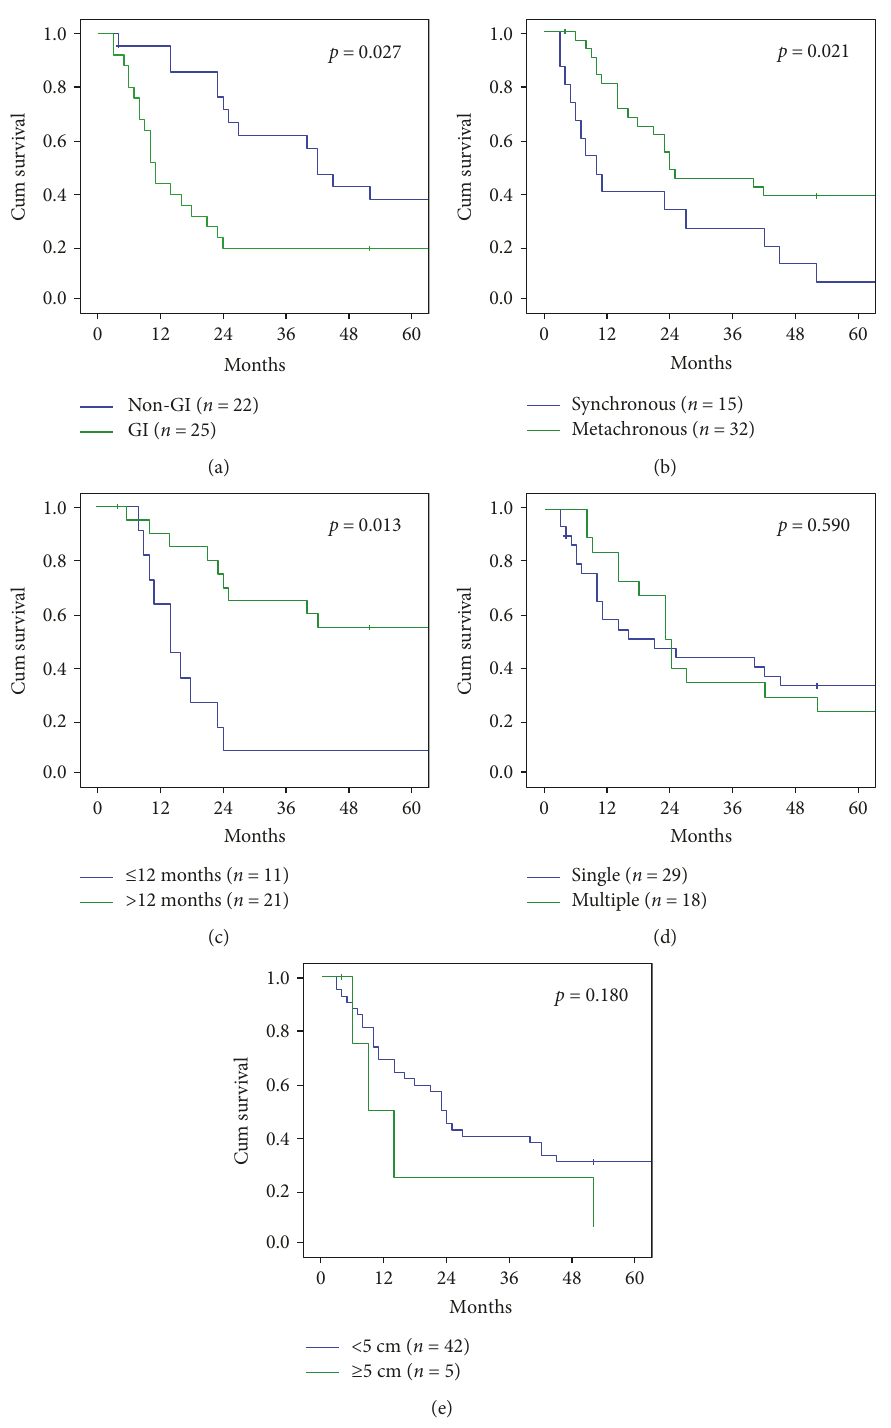
Figure 3: Overall survival according to tumor characteristics. (a) Gastrointestinal versus nongastrointestinal. (b) Synchronous versus metachronous. (c) Metachronous ≤ 12 months versus metachronous > 12 months. (d) Single versus multiple lesions. (e) Single lesions ≥ 5 cm versus <